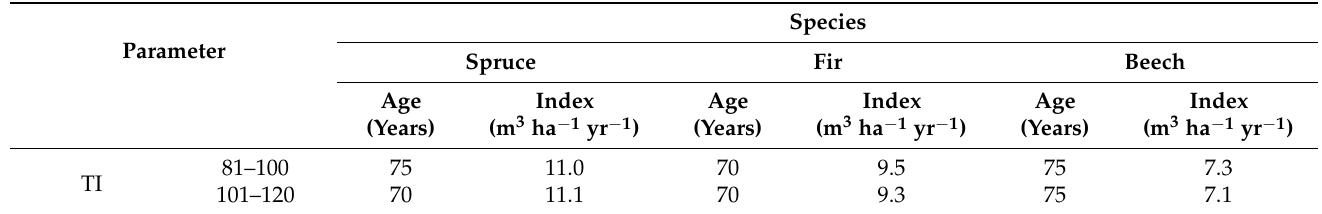
Table 5. Maximum mean annual volume